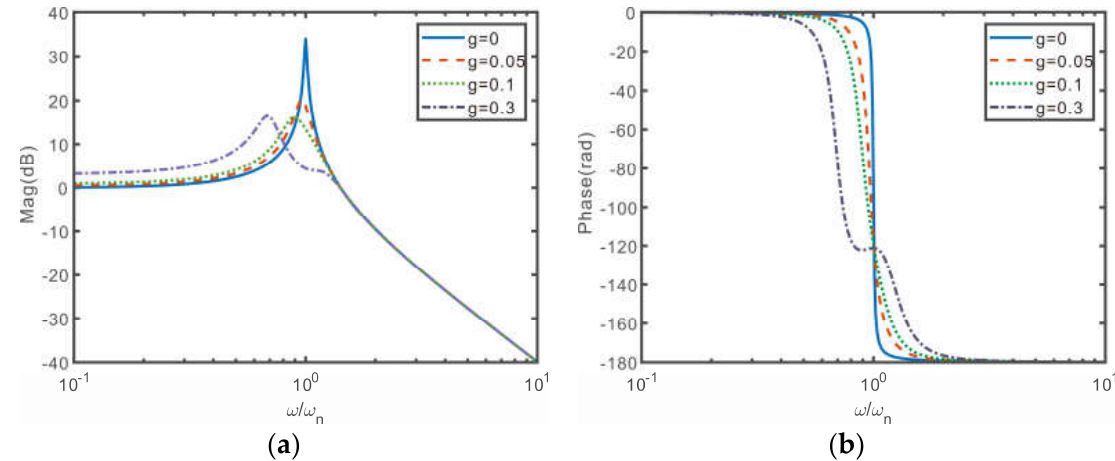
Figure 4. The Bode diagram of the closed-loop system. ( a ) Magnitude; ( b ) Phase.